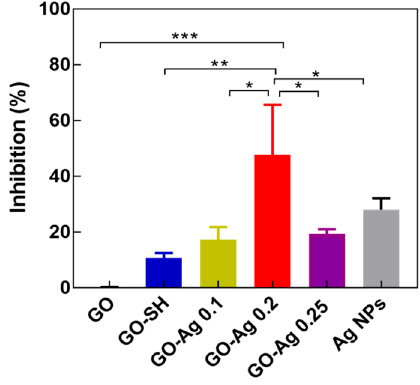
Figure 8. The inhibition percentage of S.A. bacteria treated with pristine GO and GO-Ag composite samples at a concentration of 20 ppm (*, ** and *** were represented for p < 0.05, p < 0.01, p < 0.001, respectively).